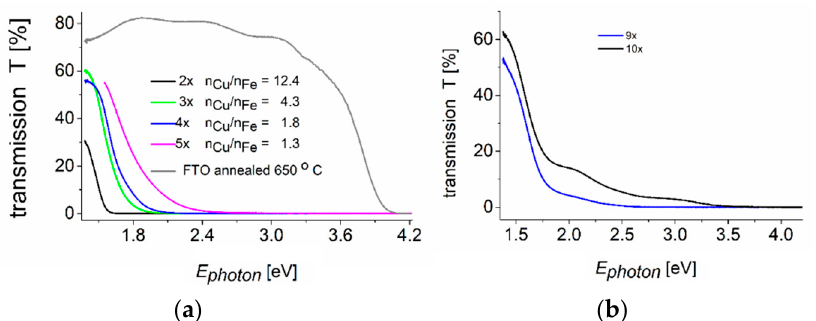
Figure 9. Transmission spectra of selected deposited films 2x, 3x, 4x, 5x ( a ) and 9x, 10x ( b ) on FTO glass substrates measured by UV-VIS optical spectrometry. All optical diagnostics was done on the films before PEC measurements.